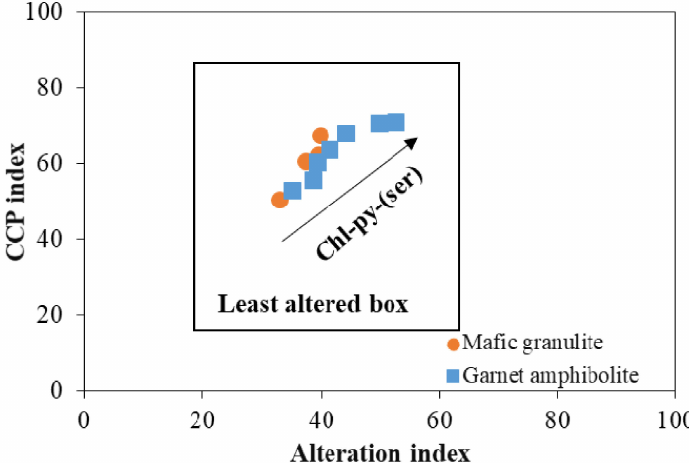
Figure 10. Alteration box plot [61] for the Anyouzok metavolcanic rocks. Overall samples fall within the least altered box and follow the chlorite alteration